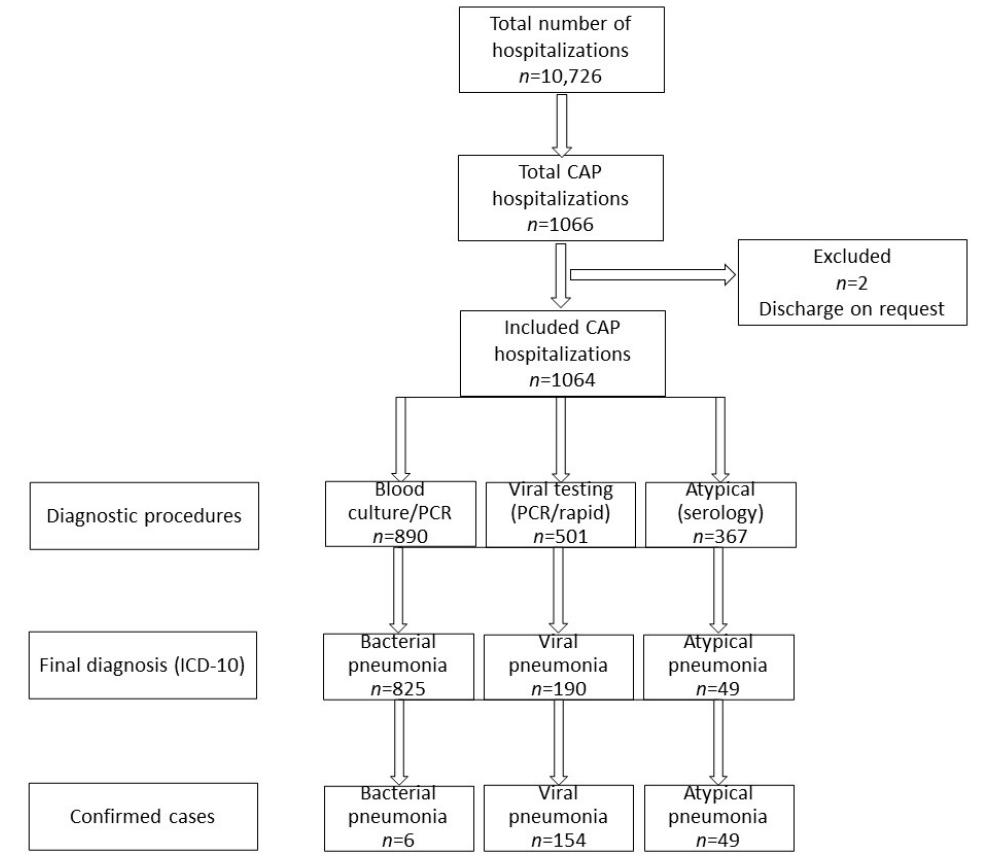
Figure 1. A flowchart of patients in the study. Note, some of the patients underwent diagnostic procedures towards more than one conditions, but finally each patient was diagnosed with onlly one condition. CAP—community-acquired pneumonia; ICD-10—International Classification of Diseases, Tenth Revision